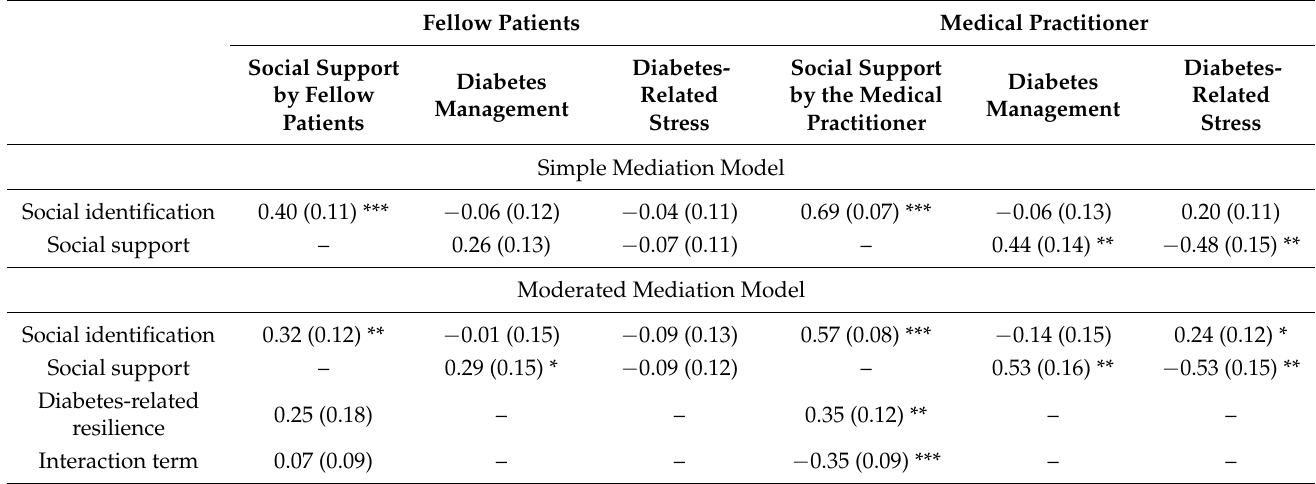
Table 4. Results of the structural equation